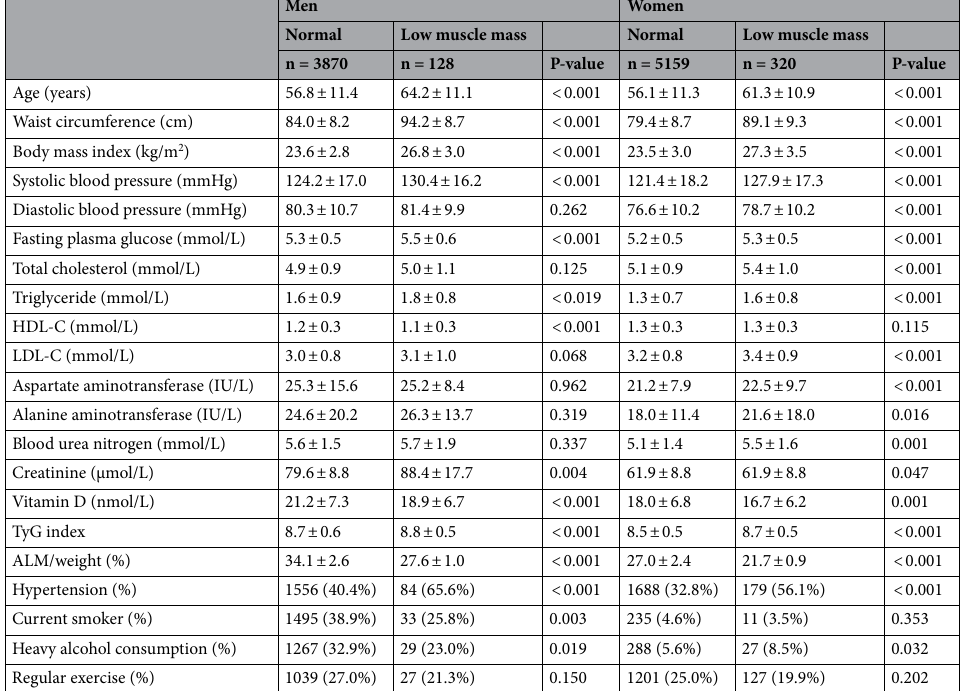
Table 2. Comparison between the normal and low muscle mass groups in men and women. Data are expressed as mean ± standard deviation or n (%). ALM appendicular lean mass; HDL-C High-density lipoprotein cholesterol; LDL-C low-density lipoprotein